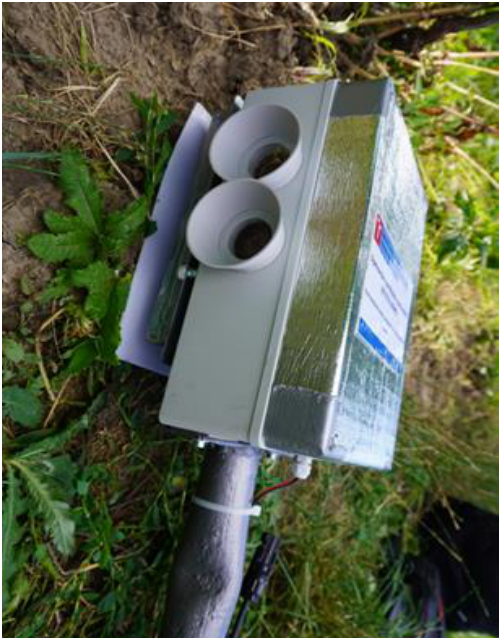
Figure 2. The optical detection and early warning unit to track a flock of birds.